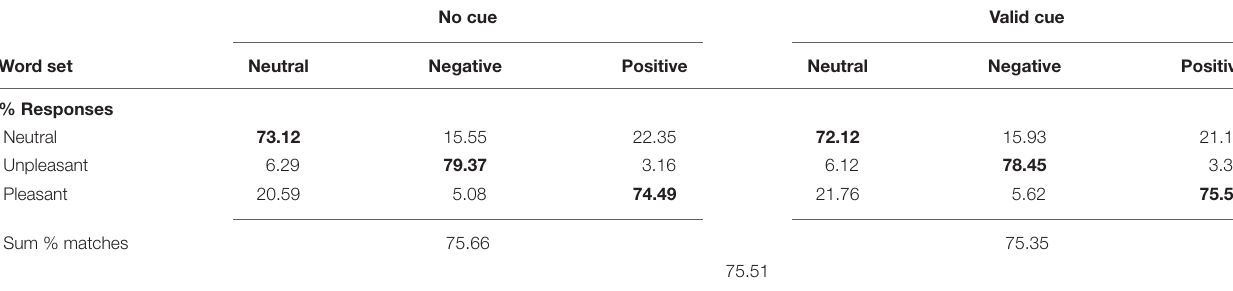
TABLE 1 | Rating responses agreeing with the preselected emotional category in percent.